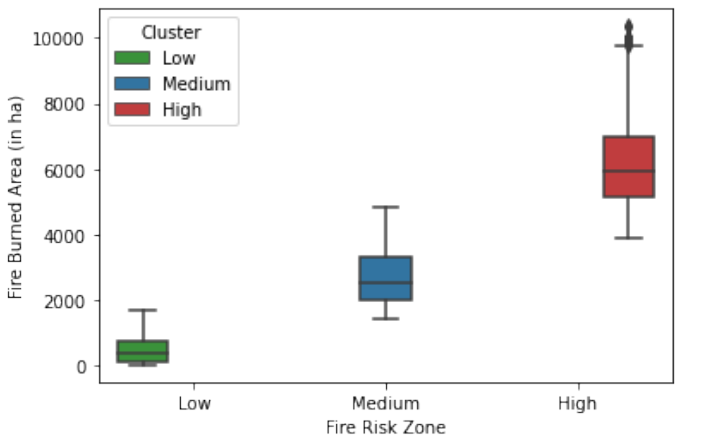
Figure 5. The statistical summary of fire areas categorized under three risk zones—low, medium, and